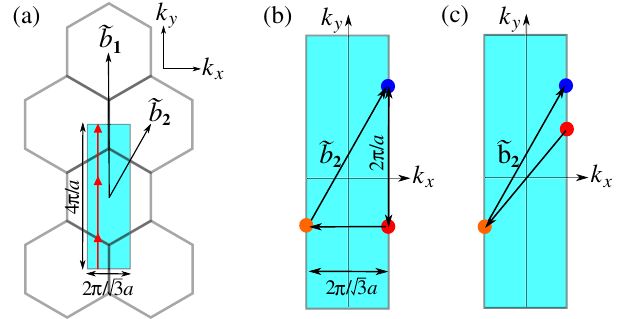
FIG. 3. (a) A constant- k two of three reciprocal-lattice vectors indicated by